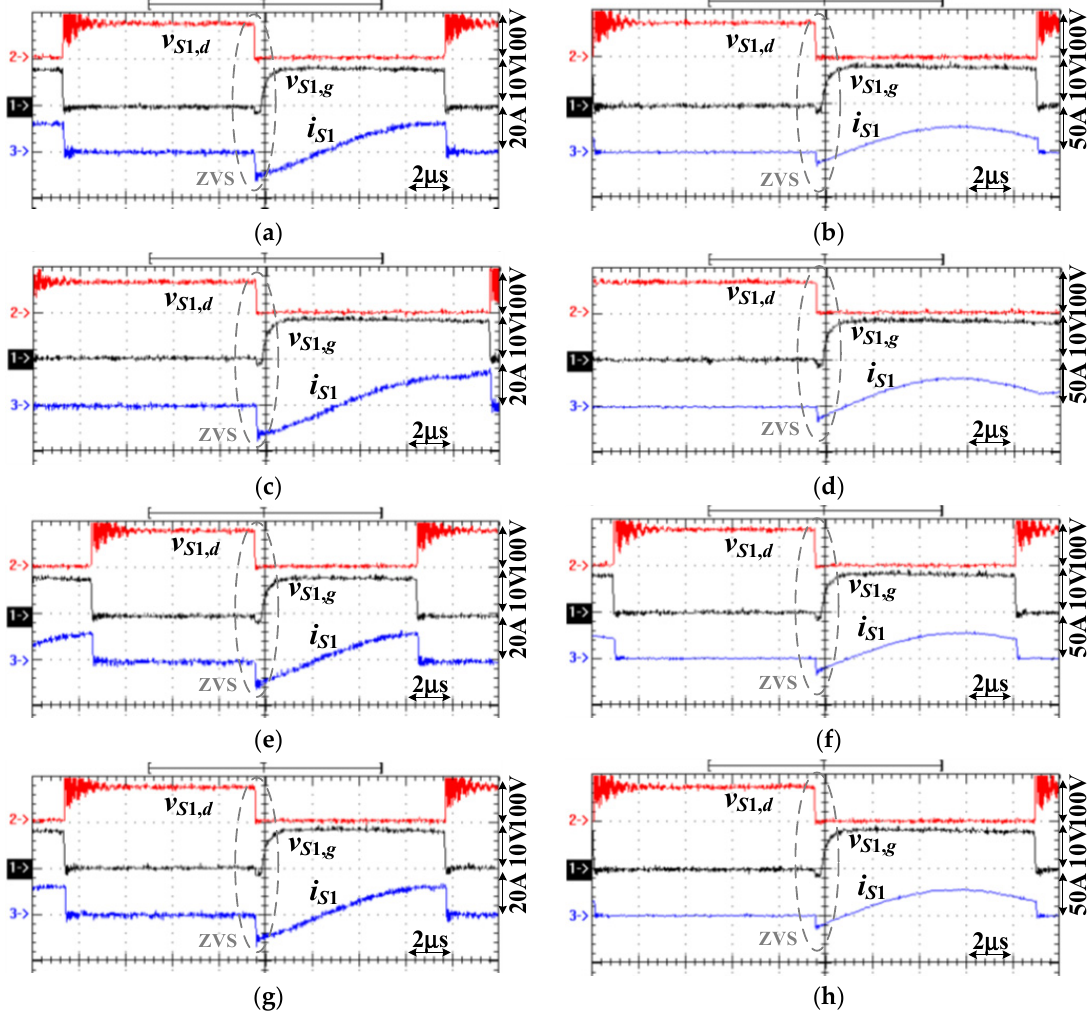
Figure 12. Experiments of switch S 1 of resonant converter at ( a ) V in = 18 V and 20% power ( b ) V in = 18 V and full power ( c ) V in = 67 V and 20% power ( d ) V in = 67 V and full power ( e ) V in = 74 V and 20% power ( f ) V in = 74 V and full power ( g ) V in = 288 V and 20% power ( h ) V in = 288 V and full power.